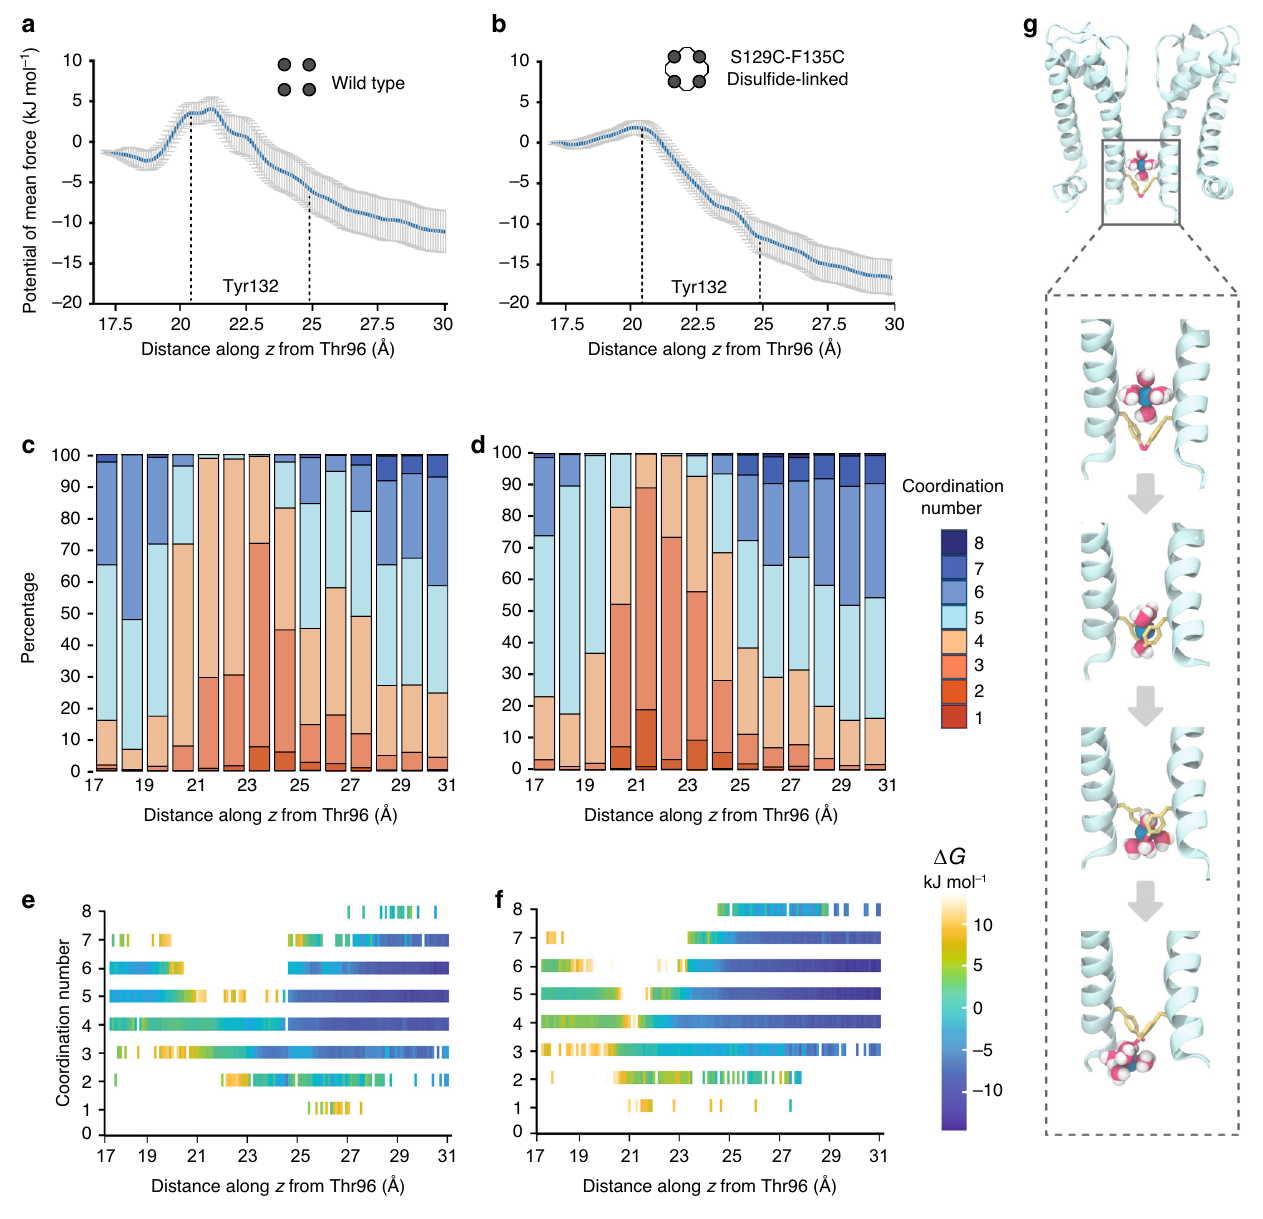
Fig. 2 Molecular dynamics simulations indicate that K + passes through the Tyr132 collar in a partially hydrated state. Wild-type panels are shown in a , c and e , and a disul fi de-linked mutant in b , d and f . a The potential of mean force along the axis of the wild-type structure is shown as a function of the distance between a K + cavity ion ‘ pulled ’ along the conduction pathway ( z axis) and the center of mass of the four Thr96 side chains (the global reaction coordinate). SEM are depicted as vertical gray bars and represents n = 200 bootstraps. The Tyr132 side chain position from C β (~20 Å) to OH (~25 Å) is indicated by dotted lines. b A comparable plot for disul fi de-linked S129C-F135C. c Normalized histograms enumerate the number of oxygen atoms coordinating K + as a function of distance from Thr96. Data are accumulated from umbrella sampling simulations of wild-type KirBac3.1. Each bin represents the number of oxygen atoms within 3.0 Å of K + , expressed as a percentage. d Histograms for disul fi de-linked S129C-F135C. e Potential of mean force (PMF) for the wild-type channel is depicted as a function of the distance along the molecular axis from Thr96 and the number of coordinating ligands per ion. f PMF for disul fi de-linked S129C-F135C. Energy units are kJ mol − 1 . g Selected structures from simulations revealing K + ions in a partially dehydrated state as they pass Tyr132. Potassium ions are represented as green spheres and water depicted in red and K + ions pass through the Tyr132 collar were compared to the entirety of the data (Supplementary Fig. 4). In all cases, the ions permeated mildly asymmetric Tyr132 collars with openings inadequate to accommodate fully hydrated ions (Supplementary Fig. 5). The mean values for the shorter and longer Tyr132-OH diagonals of the 11 structures correspond to van der Waals (vdW) spacings of 4.0 and 6.0 Å. (Supplementary Fig. 6), smaller than the time-averaged hydration diameter of K + of 6.6 Å 34 .